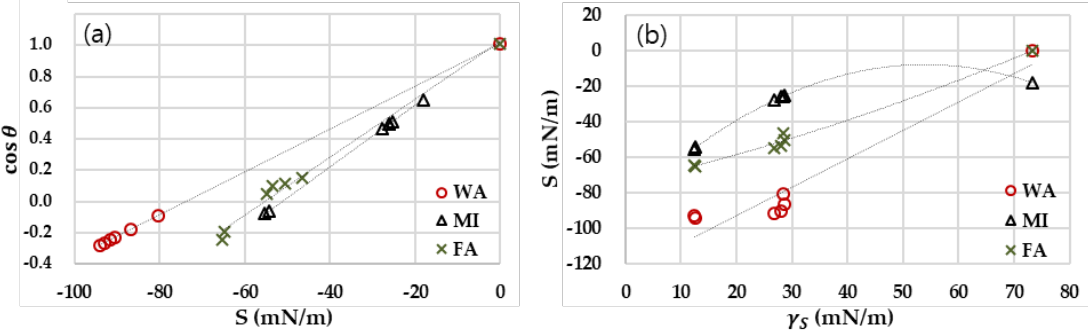
Figure 5. Spreading parameter for surface energy and wettability. ( a ) Plots of cos θ with spreading parameter; ( b ) Spreading parameter with different surface energy of the solid.